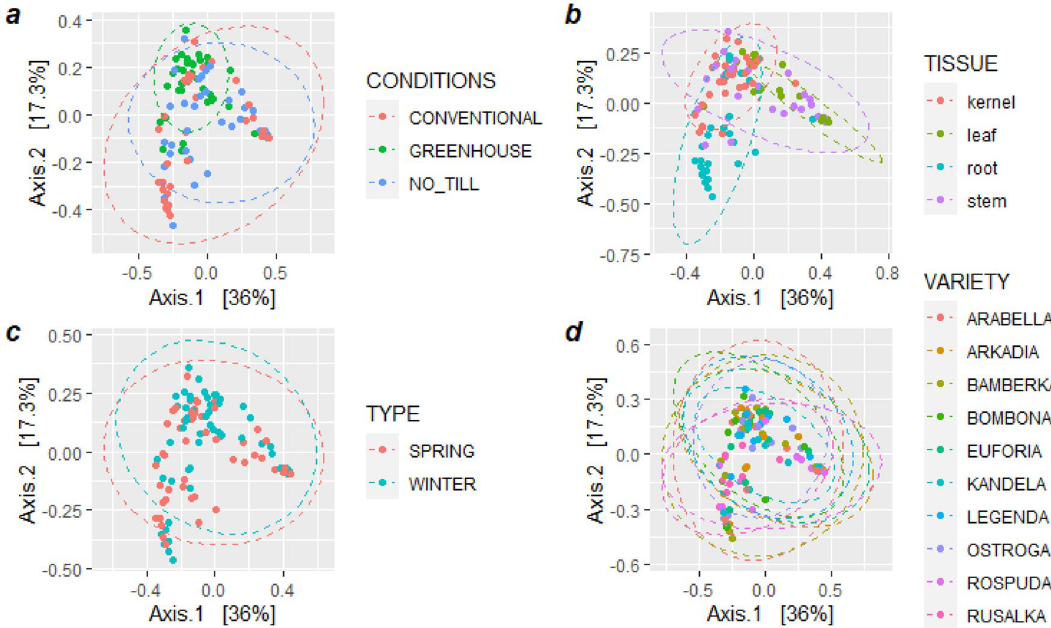
Figure 2. PCoA plots based on weighted UniFrac of the fungal community structure of wheat endosphere, depending on ( a ) growth conditions, ( b ) tissue types, ( c ) wheat forms, and ( d ) OTUs from the greenhouse were slightly separated, whereas OTUs from conventional and no_till management conditions were clustered together (Fig. 2a). Moreover, OTUs from the roots were clearly separated from each other, while stems, kernels, and leaves were clustered together (Fig. 2b). Applied growth conditions mainly affected the mycobiome of the wheat roots, leaves and stems (Fig. 3a). Samples from 2 wheat forms and 10 cultivars clustered together (Fig. 2c,d). The PER- MANOVA analysis on weighted UniFrac distance revealed that the growth management strategy type and part of the plant tissue significantly impacted the endogenous fungal community in wheat ( p < 0.001). The adonis tests and the PCoA observation found that the tissue type explained approximately 25% (R2 (wUniFrac) = 0.25063) of the variation of communities in the dataset, while growth conditions account for 9% (R2 (wUniFrac) = 0.0926) of the variation. Betadisper demonstrated that „conditions” and „tissue” groups had a similar dispersion (Conditions: F = 1.9771, p = 0.13; Tissue: F = 2.3828, p = 0.073), thus the observed significant differences were not a result of heterogeneity of dispersions. OTUs with significantly different abundances in various tissue types and growth conditions, were identified and demonstrated in Fig. 4. The wheat cultivars (p = 0.979) and forms (p = 0.389) had an insignificant effect on the fungal community structures in the entire data set (Fig. 2c,d), and on individual tissues (Fig. 3b,c). The abundance of fungal endophytes in wheat. The level of fungal colonization in the inner part of the wheat plants was lowest in greenhouse samples (mean per sample = ~ 1359 ITS copies) compared to the conventional and no_till plant groups (mean per sample = ~ 23,530 and ~ 29,660 ITS copies, respectively). The most abundant in endogenous fungi were the roots, while the kernels and stems demonstrated a low level of endophytes colo- nization. The winter wheat forms as well as Arkadia and Bamberka manifested the highest endogenous fungal abundance. Endogenous fungal community composition. The fungal member classes of Dothideomycetes and Sordariomy- cetes dominated the Ascomycota phylum in all the analyzed groups (Fig. 5). Furthermore, the Pucciniomycetes class ( Basidiomycota phylum) has become widespread in the leaves from field plants. Interestingly, these fungi were also identified in the stems and kernels of the studied plants. The composition of the endogenous fungal communities differs among the analyzed growth conditions (Figs. 5, 6, 7). In the conventional and the no_till samples, the Pleosporales and Pucciniales orders were the most dominant. In the greenhouse samples, there was an advantage of the Eurotiales , with Hypocreales . The Pucciniales fungi were observed exclusively in field- collected plants (conventional and no_till). Further, the Chaetothyriales , Dothideales , and Xylariales fungi were absent in the greenhouse samples, though present in the field-collected samples. However, Conioscyphales , and Thelebolales were identified mostly in the greenhouse samples, whereas Onygenales order and Malasseziomycetes classes were absent in the no_till field samples. Glomeromycota phylum was identified mainly in the conven- tional samples ( Glomeromycetes and Paraglomeromycetes classes) and in smaller amounts in no_till field condi- tions ( Paraglomeromycetes). The clear differences in endophytic fungal community structure were also observed between studied wheat tissue (Figs. 5, 7).